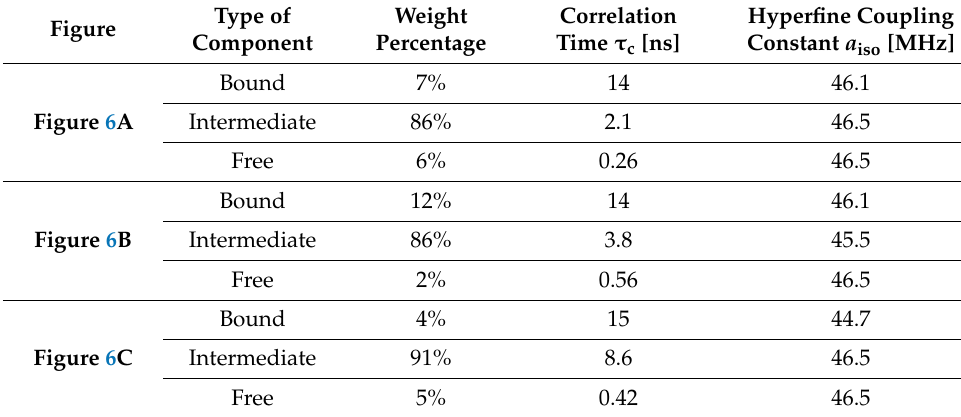
Table 2. Parameters of spectral simulation of Figure 6.